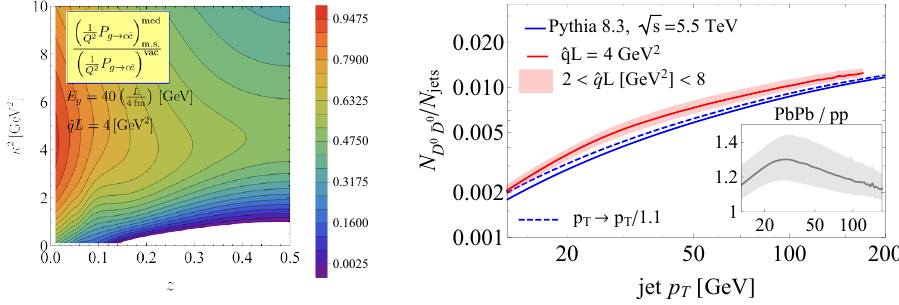
Figure 1. Left (from [8]): The ratio of the medium-modified splitting function to the vacuum one shows the characteristic momentum broadening and enhanced production of c ¯ c pairs. Right (from [10]): The fraction of jets carrying a D 0 ¯ D 0 -tag in √ s = 5 . 5TeV mid-central pp collisions (blue line), and in central PbPb collisions (red band). The blue dashed line is included to take into account jet energy-loss estimated as ∆ p T / p T 10% of inclusive ≈